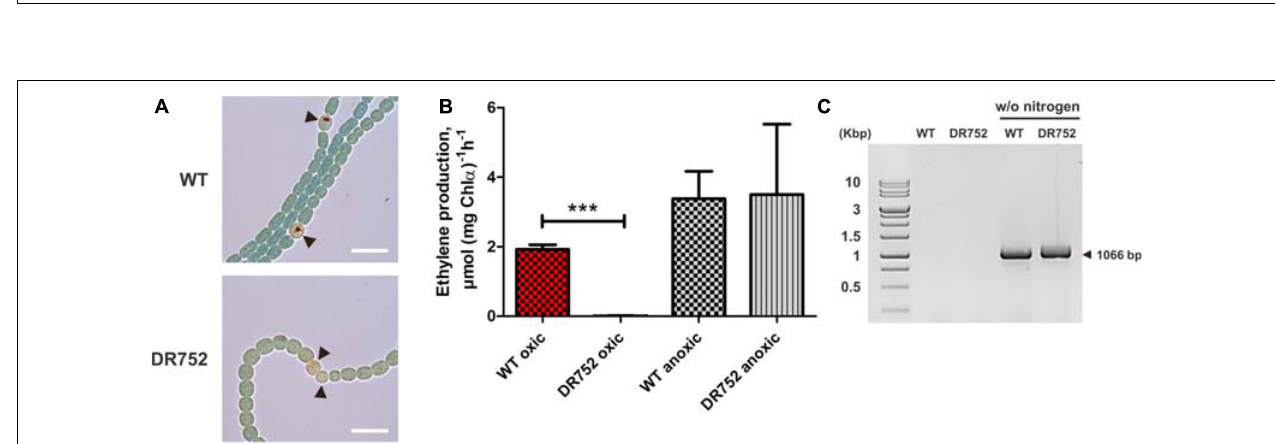
FIGURE 2 | Nitrogenase activity and nifHDK operon rearrangement assessment. (A) Bright field images of nitrogen-starved filaments of WT and mutant DR752 after incubation with triphenyl tetrazolium chloride (TTC). Black arrowheads point to the heterocysts. TTC reduces to dark formazan crystals under microoxic conditions. Scale bar, 10 µ m. (B) Assessment of the nitrogenase activity of WT and mutant DR752 under oxic and anoxic conditions. Filaments were incubated for 48 h in nitrogen-free medium before measuring the nitrogenase activity using the acetylene reduction assay. Data are representative of two independent experiments. The histogram shows the mean values ± standard deviation of three experimental replicates. Student’s t -test P -value is indicated as asterisks (*** P < 0.0001). (C) The nifD rearrangement in WT and mutant DR752 after 72 h of nitrogen step-down was shown by PCR using primers (Ava903 FW and 919 Rv) left and right to the 11-kb insertion element as listed in Supplementary Table 2